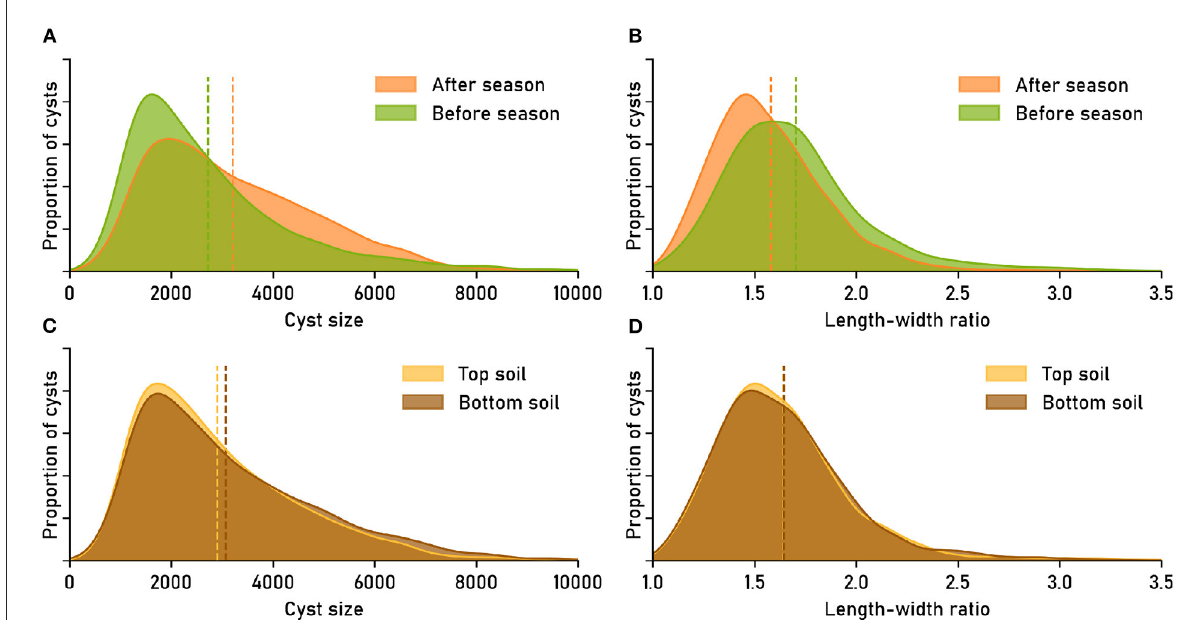
FIGURE4 Image-based phenotyping reveals that nematode populations have characteristic phenotypical features. The features “cyst size” (area in pixels) and “length-width ratio” were derived directly from the cyst segmentation masks. Feature distributions show the relative amount of cysts that have a certain feature value. Dashed lines mark the means of the distributions. Data set: Cyst-Count (clean version without debris; cp. Supplementary Figure S2 for the version with debris particles). (A,B) Nematode cyst populations split by factor time_point : sampled “before season” (April) vs. “after season” (October). (C,D) Nematode cyst populations split by factor soil_type : sampled from “top soil” (0–30 cm) vs. “sub soil” (31–60